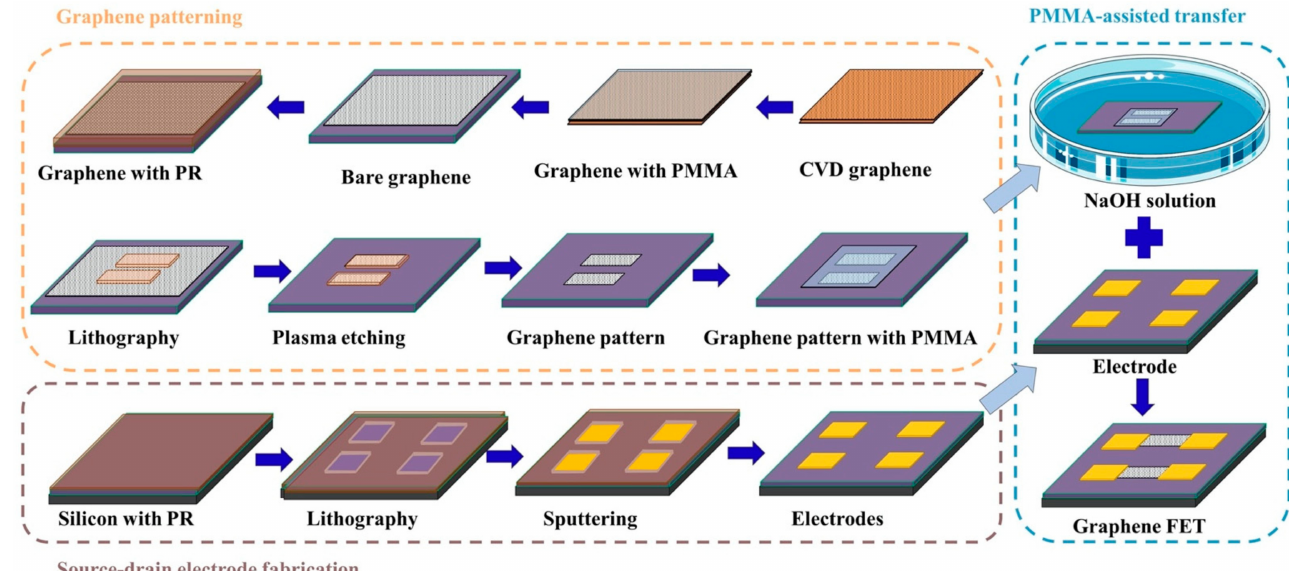
Figure 4. The fabrication process of the indole